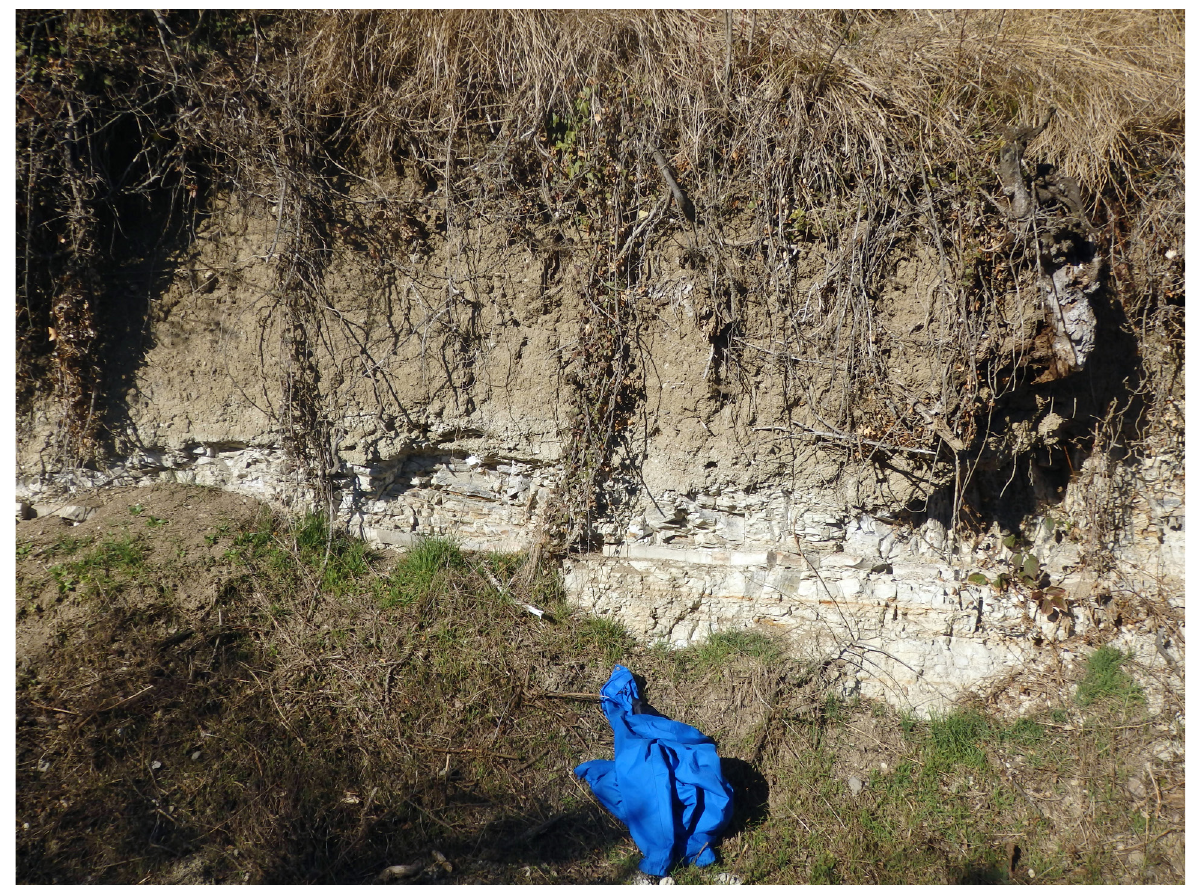
Fig. 7. Common conditions of an exposure of Oligocene sedimentary outcrops; example of CF1515 geosite at Rue de Trémonteix . Soil and colluvium top the small exposure, with a grassy